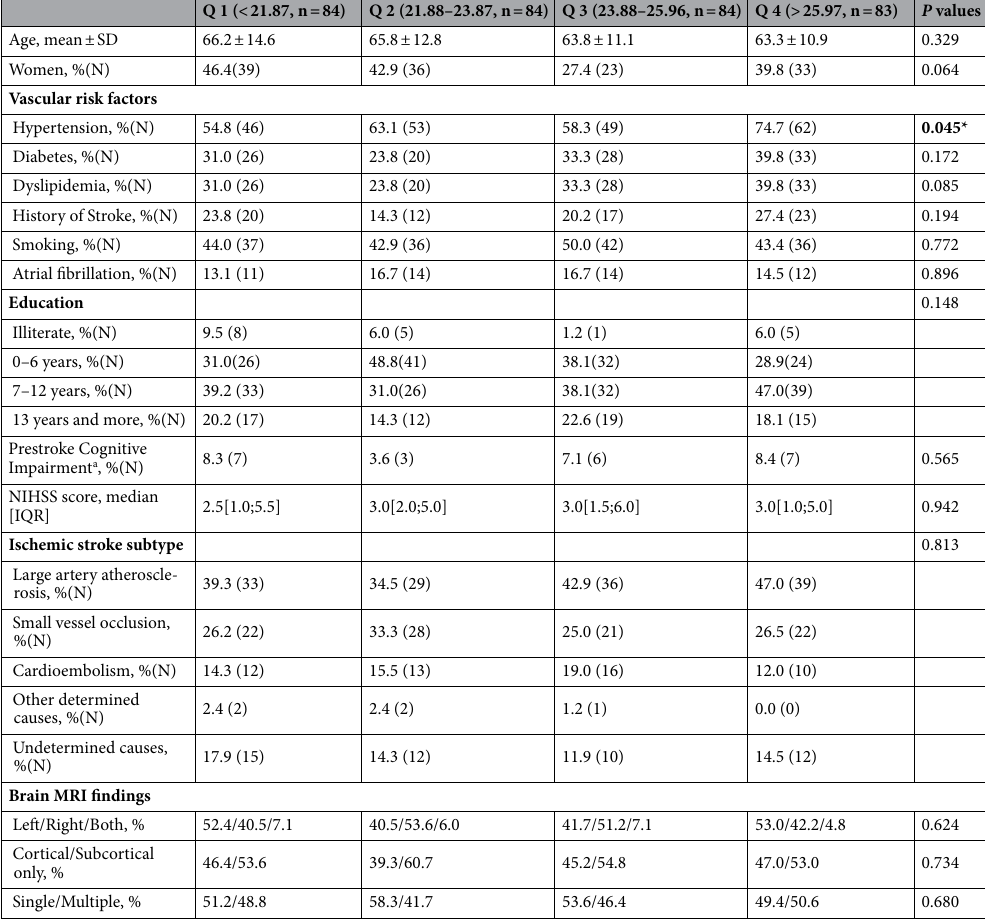
Table 1. Clinical Characteristics according to the quartiles of body mass index. a Pre-stroke cognitive impairment was evaluated with the Informant Questionnaire on Cognitive Decline in the Elderly (IQCODE). Bold values followed by * are significant at α = 0.05. NIHSS National Institute of Health Stroke Scales, SD Standard deviation, IQR Interquartile range, MRI Magnetic Resonance